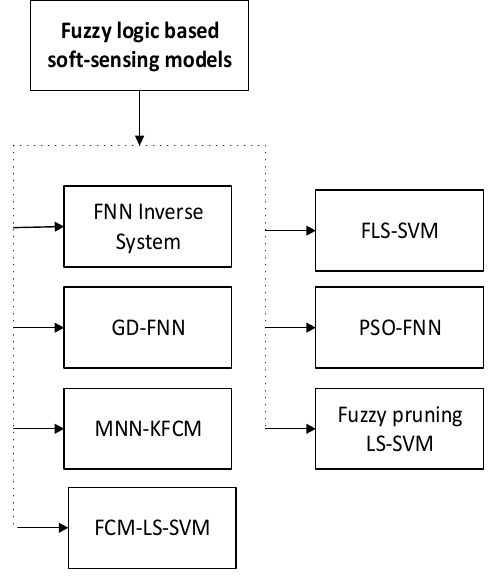
Figure 7. FL-based soft-sensing models (abbreviations are listed in Table